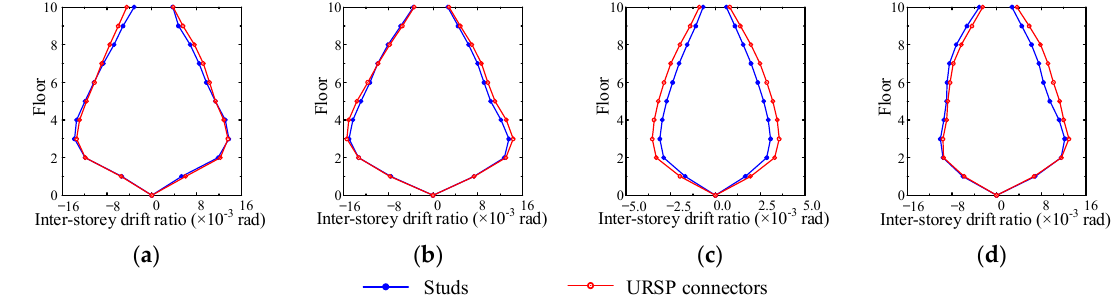
Figure 12. Inter-story drift ratio envelopes: ( a ) case XL1; ( b ) case YL1; ( c ) case YS1; ( d ) case XL2.